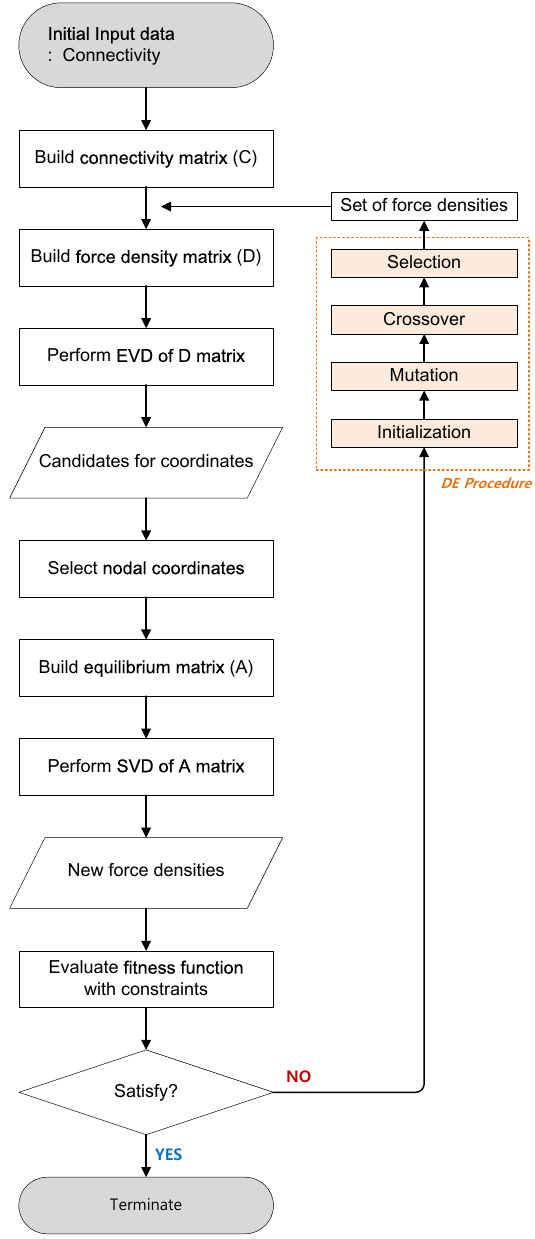
Figure 4. Flowchart of the conventional form-finding process of tensegrity structures using the